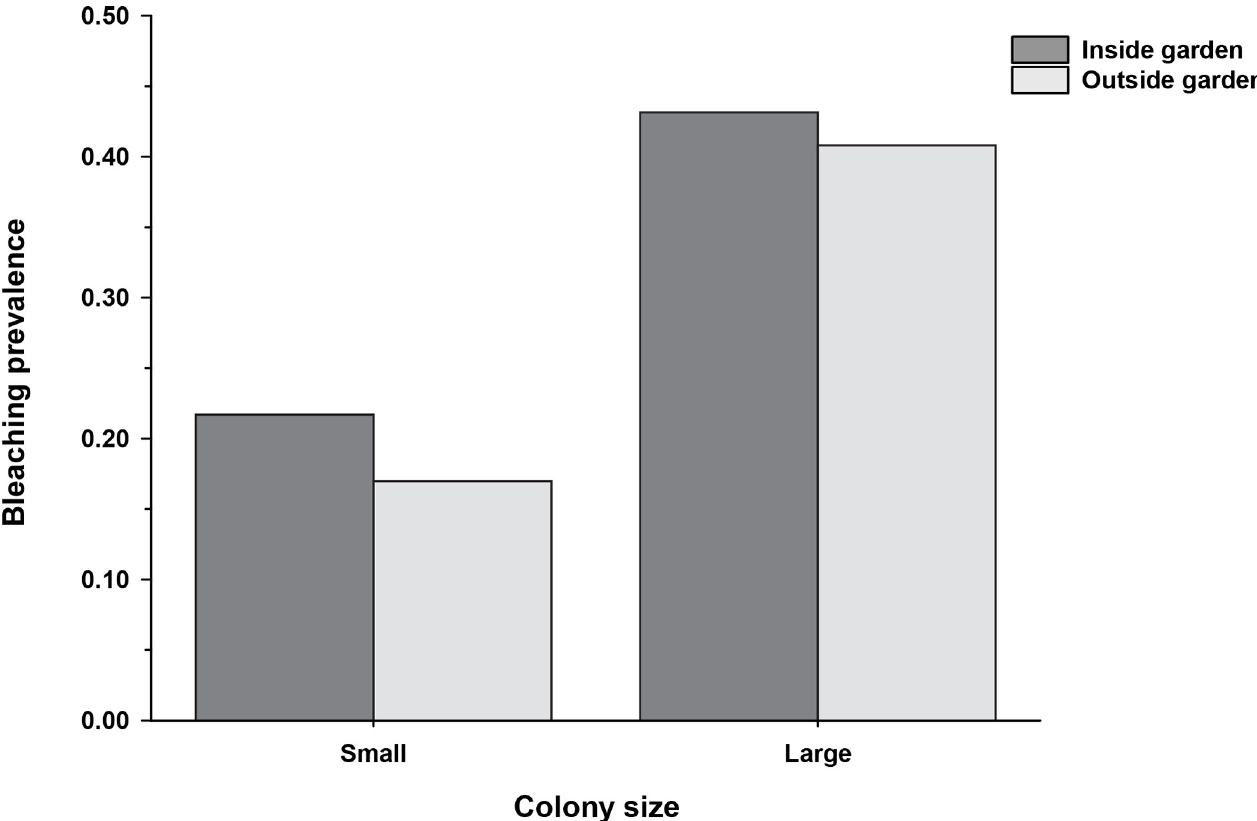
Fig 2. Bleaching prevalence as a function of farmerfish garden status. Bleaching prevalence (proportion of the sampled colonies that bleached) by colony size class as a function of farmerfish garden status for the 1,137 Pocillopora encountered on 178 bommies (number of bleached colonies: small: N = 105 inside, 53 outside; large: N = 126 inside, 20 outside; see Fig 1 for the total coral numbers by size and garden